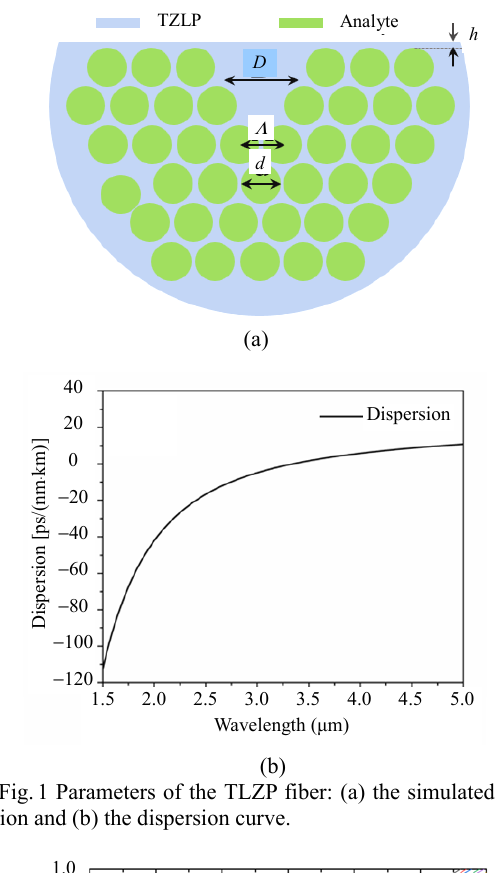
Fig. 1 Parameters of the TLZP fiber: (a) the simulated cross section and (b) the dispersion curve.